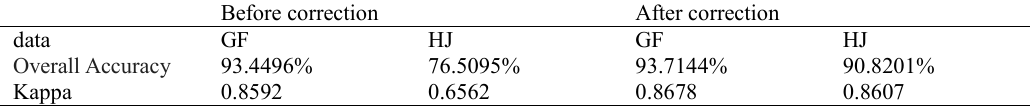
Table.3.3. Overall accuracy and kappa before and after topographic correction Before correction After